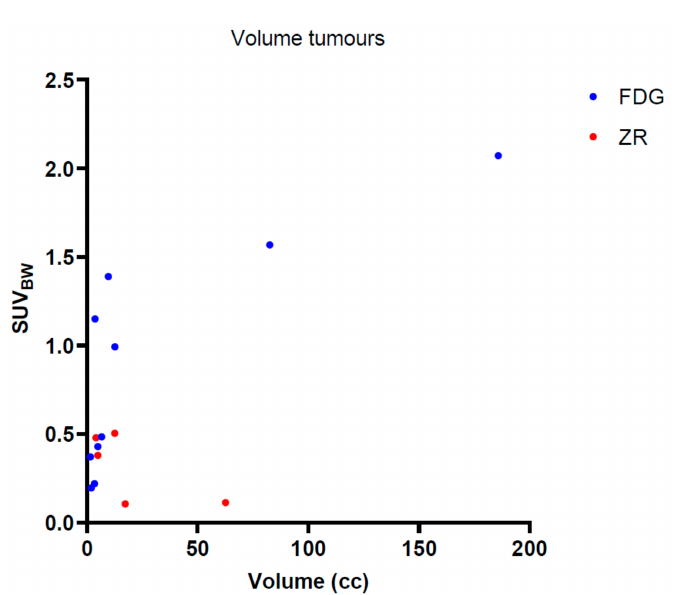
Figure A1. Volume (cc) and SUV BW distribution of the tumours in the 18 F-FDG PET and the 89 Zr- rituximab PET scans (test